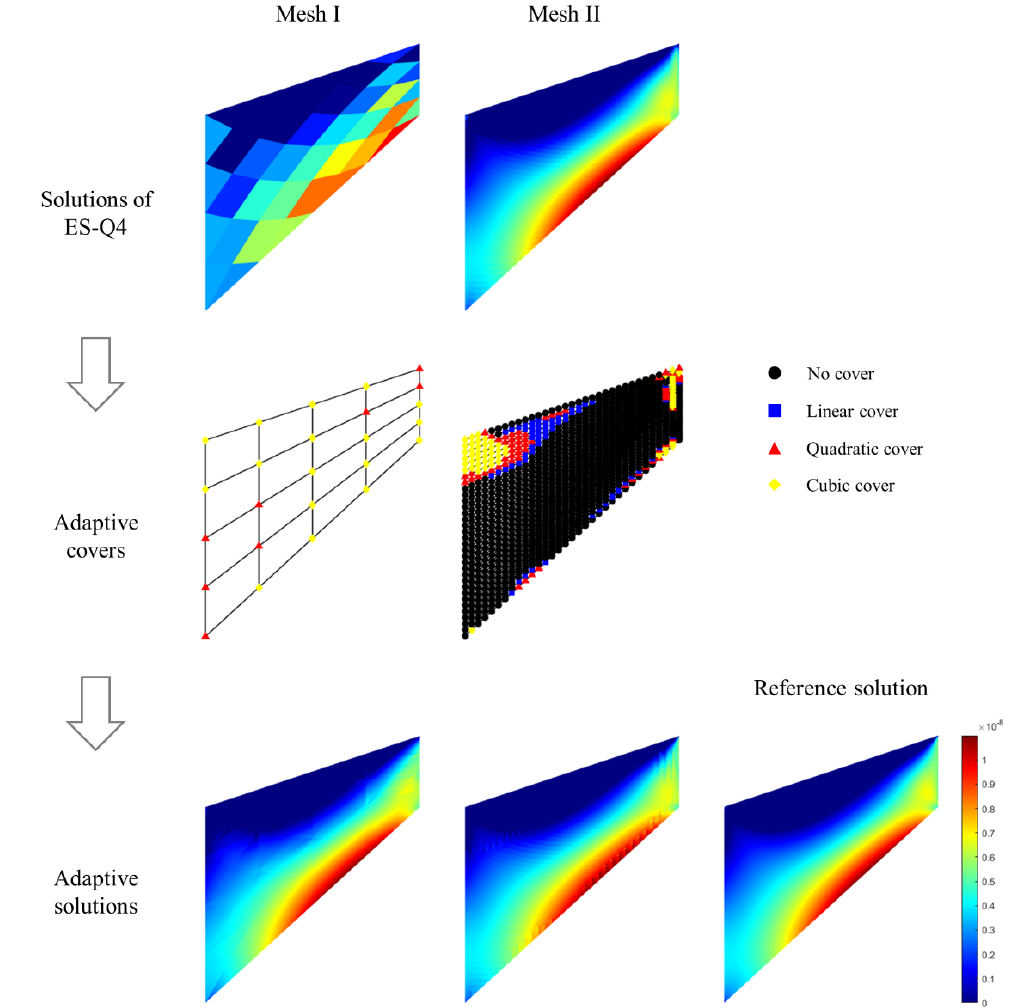
Figure 6. Strain ( ε xy ) predictions obtained by the ES-Q4 and the proposed adaptive enrichment scheme for the Cook’s skew beam problem.